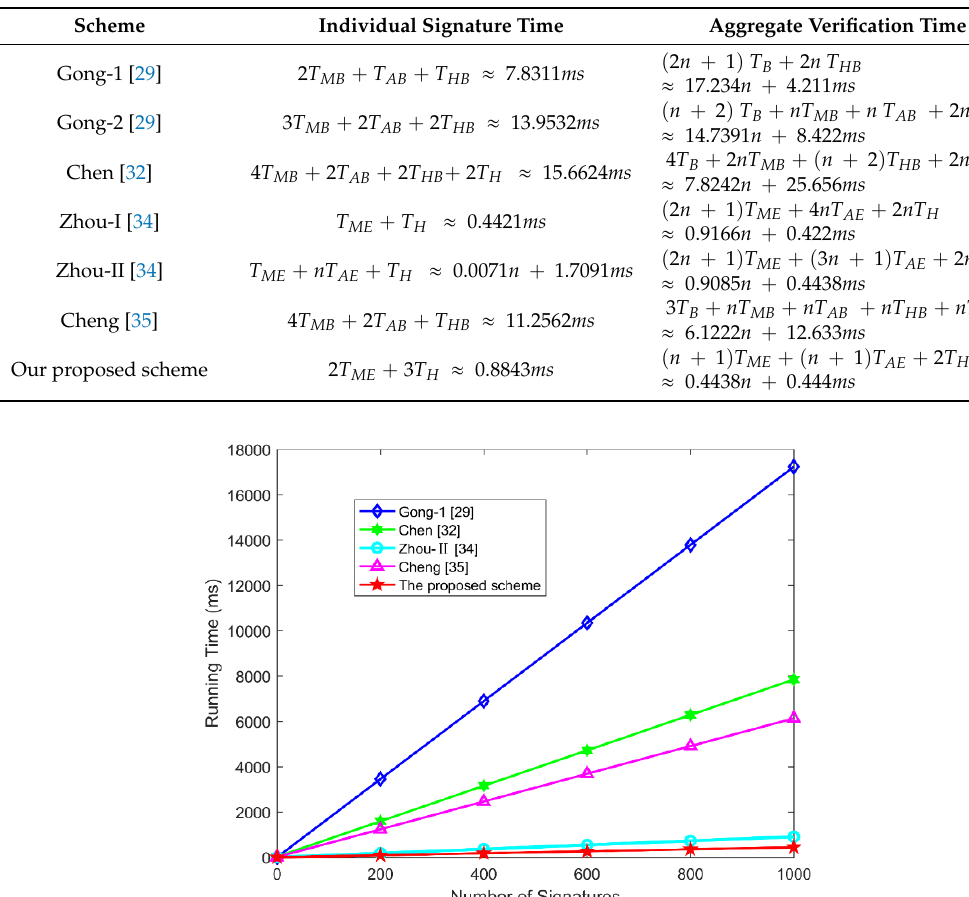
Table 5. The comparison of computation cost.